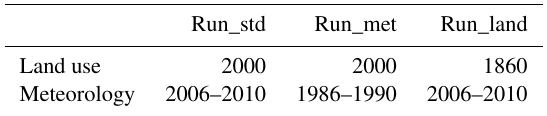
Table 2. GEOS-Chem simulations with the input data time listed to quantify surface ozone changes driven by historical climate and land use